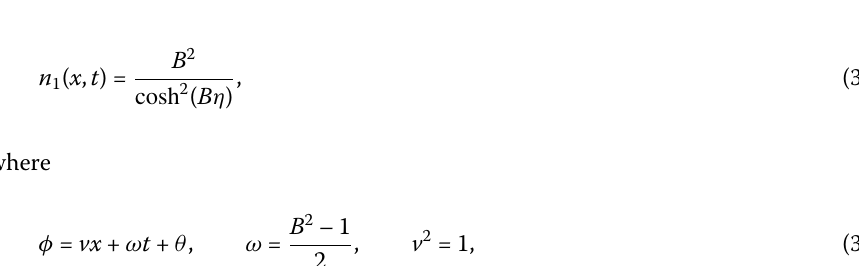
√ 3, M = 1 and v = 1: ( a ) the real part of u ; ( b ) the modulus of